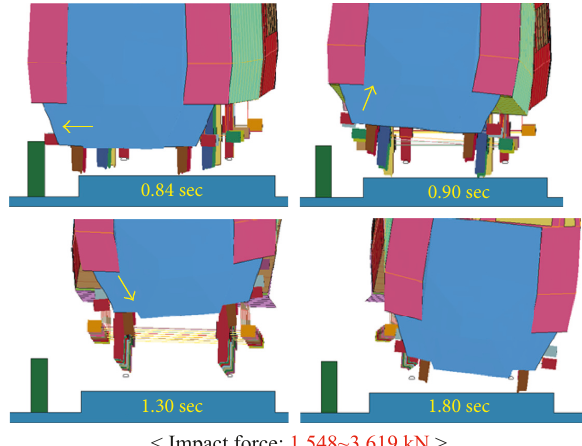
Figure 11: Derailment-collision behavior and impact force (distance effect 2).